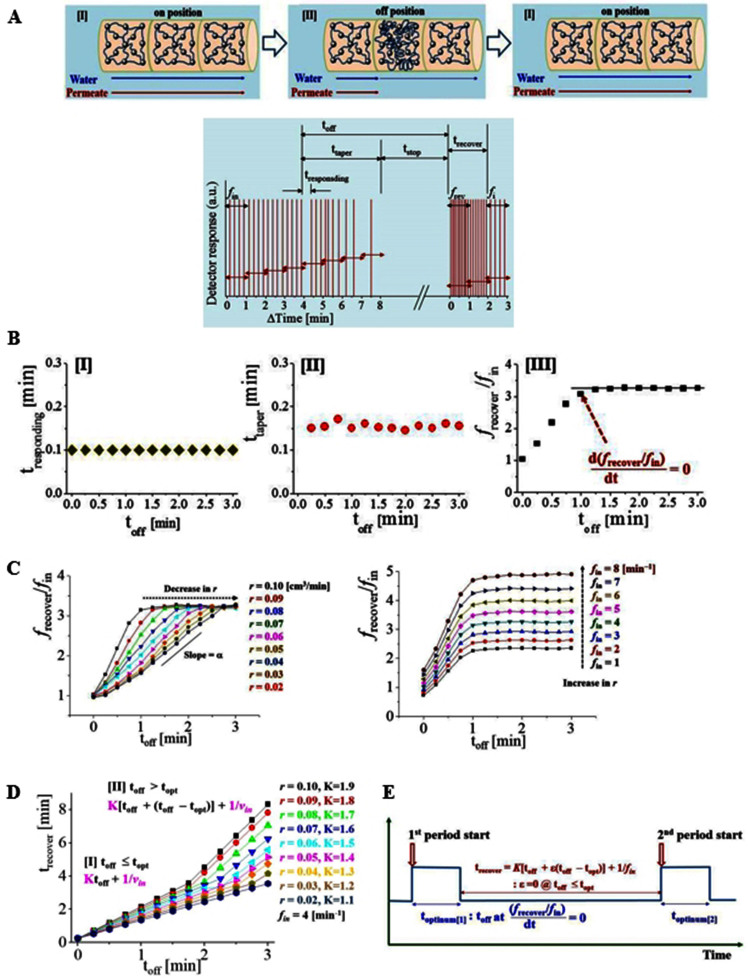
(a) Design of the contractile action on flow. By repeating on−off−on position, one valve function is designed (upper). Representative data of the one-valve system. During the designed off-time (toff), the inlet flow stops. During the taper time (ttaper), detection of permeate molecules slows followed by complete stop-time (tstop). Right after the toff starts, there is a responding time (tresponding) at which the flow stops suddenly and generates back pressure inside the cell. According to the inlet frequency (fin), the outlet frequency is modulated. Right after the toff, the first maximum outlet frequency is determined as recover frequency (frecover) after that ith frequency is determined in a sequence. (b) [I] toff vs. tresponding [II] toff vs. ttaper. tresponding and ttaper are independent of toff, reflecting system-specific features. [III] toff vs. maximum normalized frequency (frecover/fin). The frequency increase is saturated at a critical point, so the optimum time (toptinum) is determined. (c) toff vs. frecover/fin with changing r (left) and fin (right). The critical point move to higher toff by decreasing r, whereas a higher fin contributes to the increase in the magnitude of frecover/fin. (d) Fitting results of the trecover vs. toff in the two regions: [I] in the range of toff ≤ topt, K(r) toff + 1/fin relation is satisfied. [II] in the range of toff > topt, K(r) [toff + (toff − topt)] + 1/fin relation is applied. The proportional factor K is also a function of r. (e) Summary of one periodicity composed of toff and trecover as a function of toff, toptinum, frecover and fin.